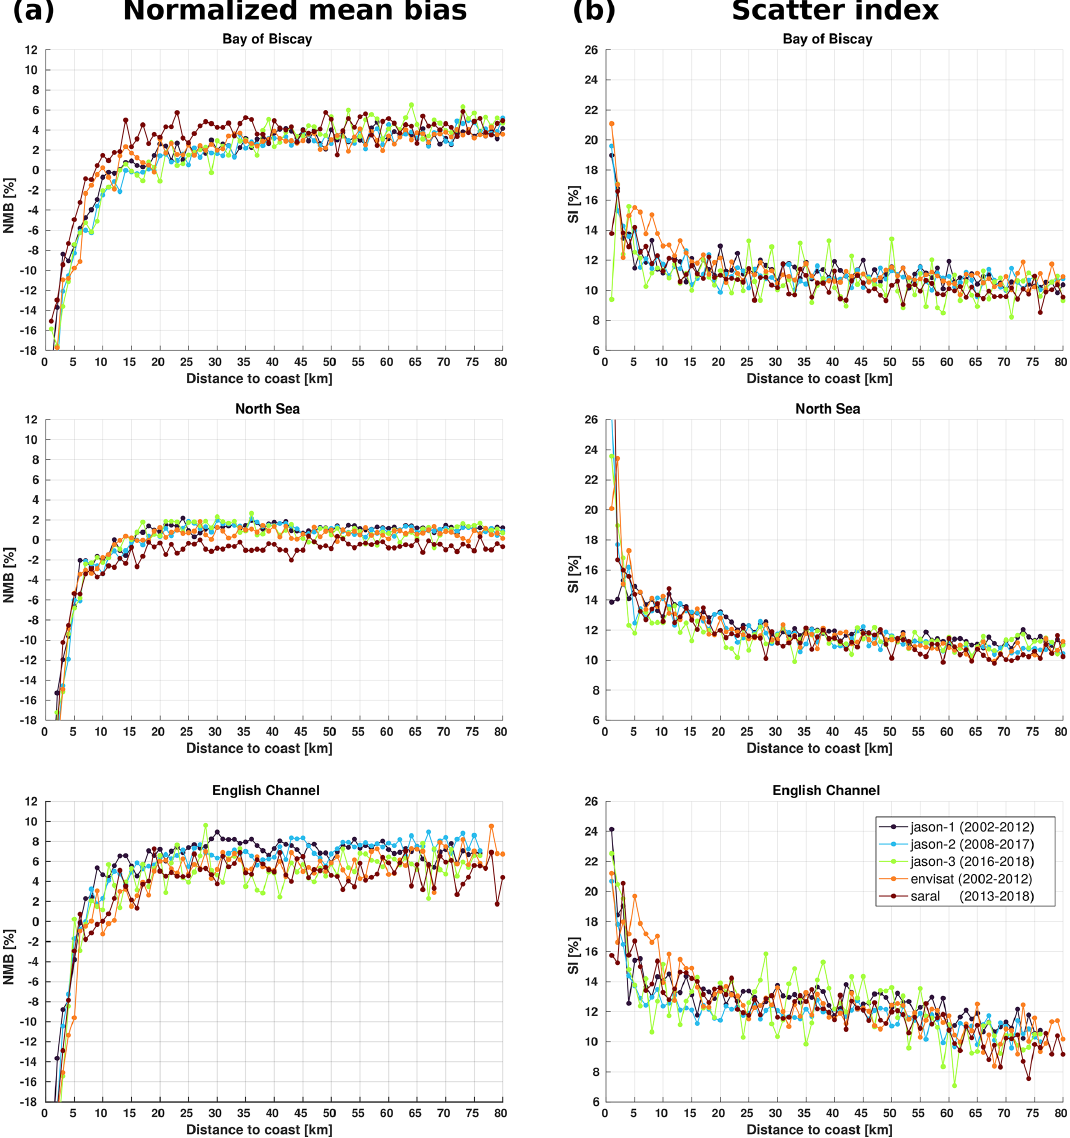
Figure 17. (a) Bias (NMB) and (b) scatter (SI) for wave heights as a function of distance to the coast (WW3 – altimeter wave height). Bin width is